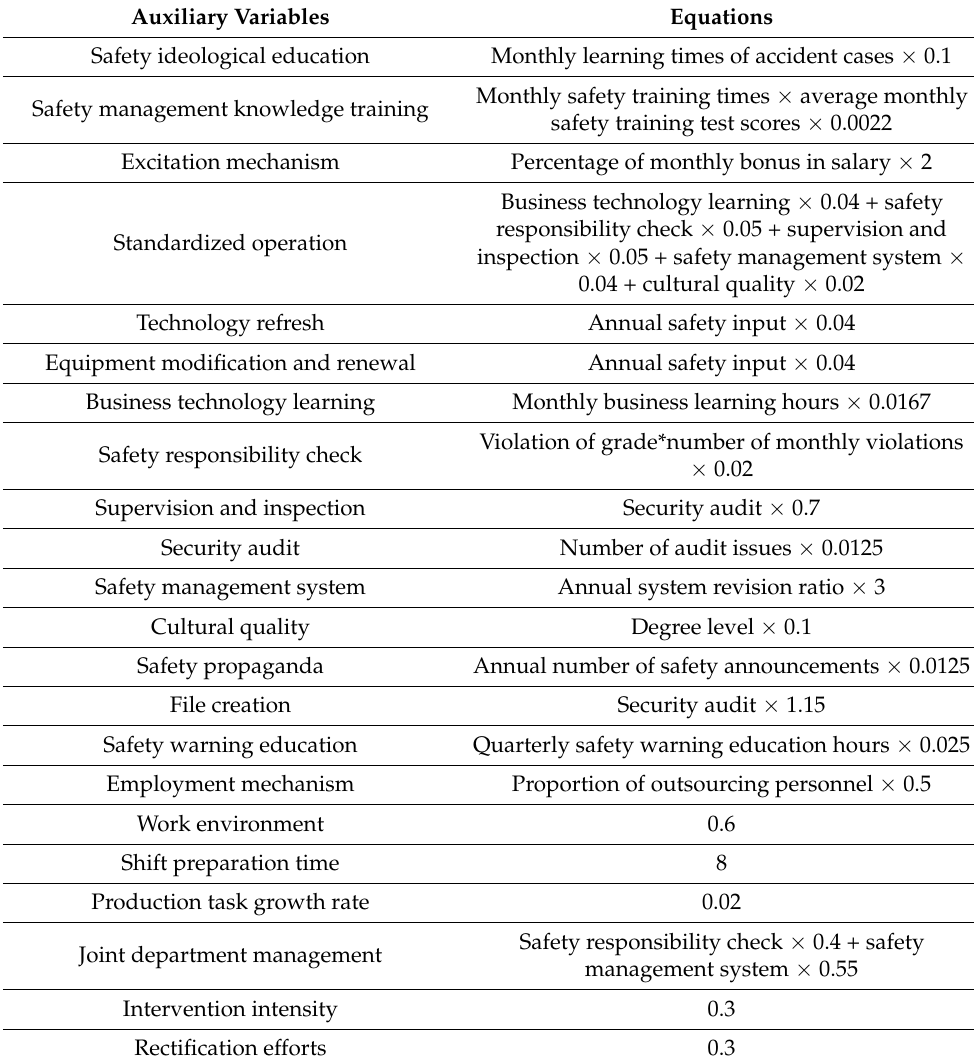
Table 5. System auxiliary